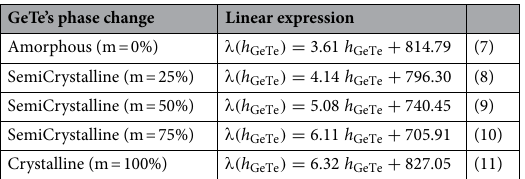
Table 1. Linearization of the absorber resonant peaks with h GeTe .